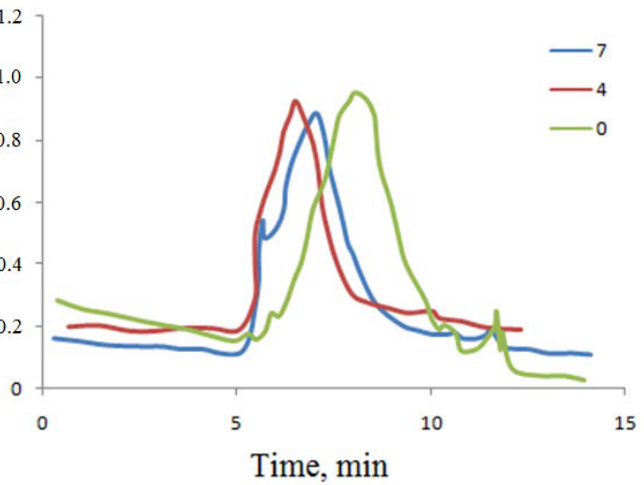
Table 2. The molecular weight distribution of polymers SPPQ.